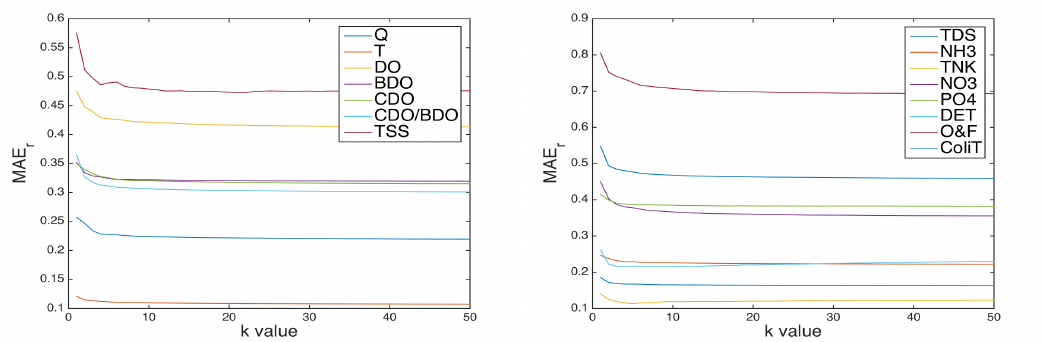
Figure 3. Behavior of MAE r for different k values.